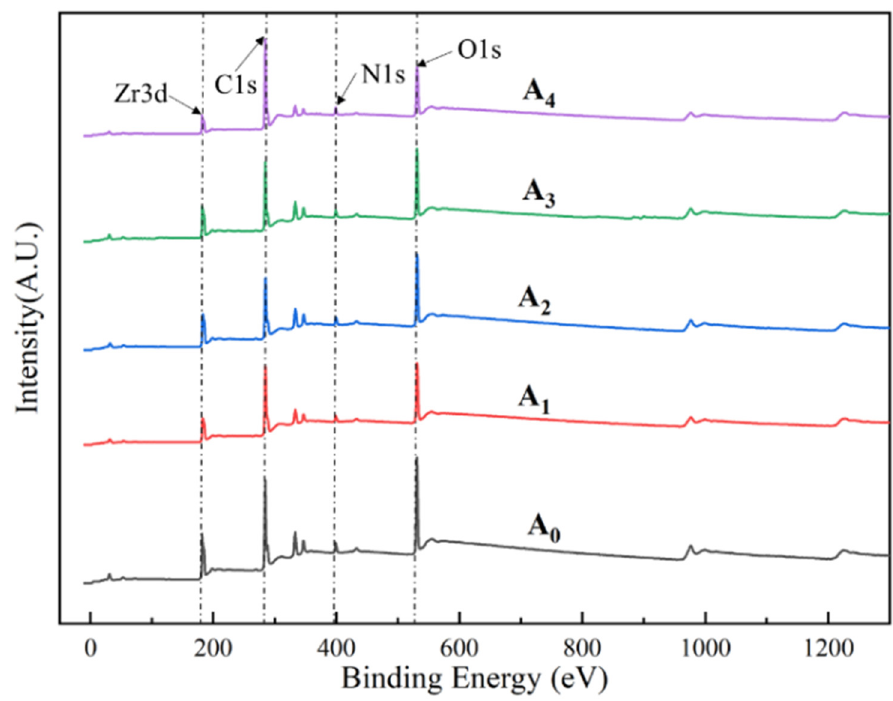
Figure 4. X − ray electron spectrometer (XPS) profiles of the UiO − 66 − NH 2 system synthesized under Figure 4. X-ray electron spectrometer (XPS) profiles of the UiO-66-NH 2 system synthesized under conditions of varying silver doping levels. conditions of varying silver doping